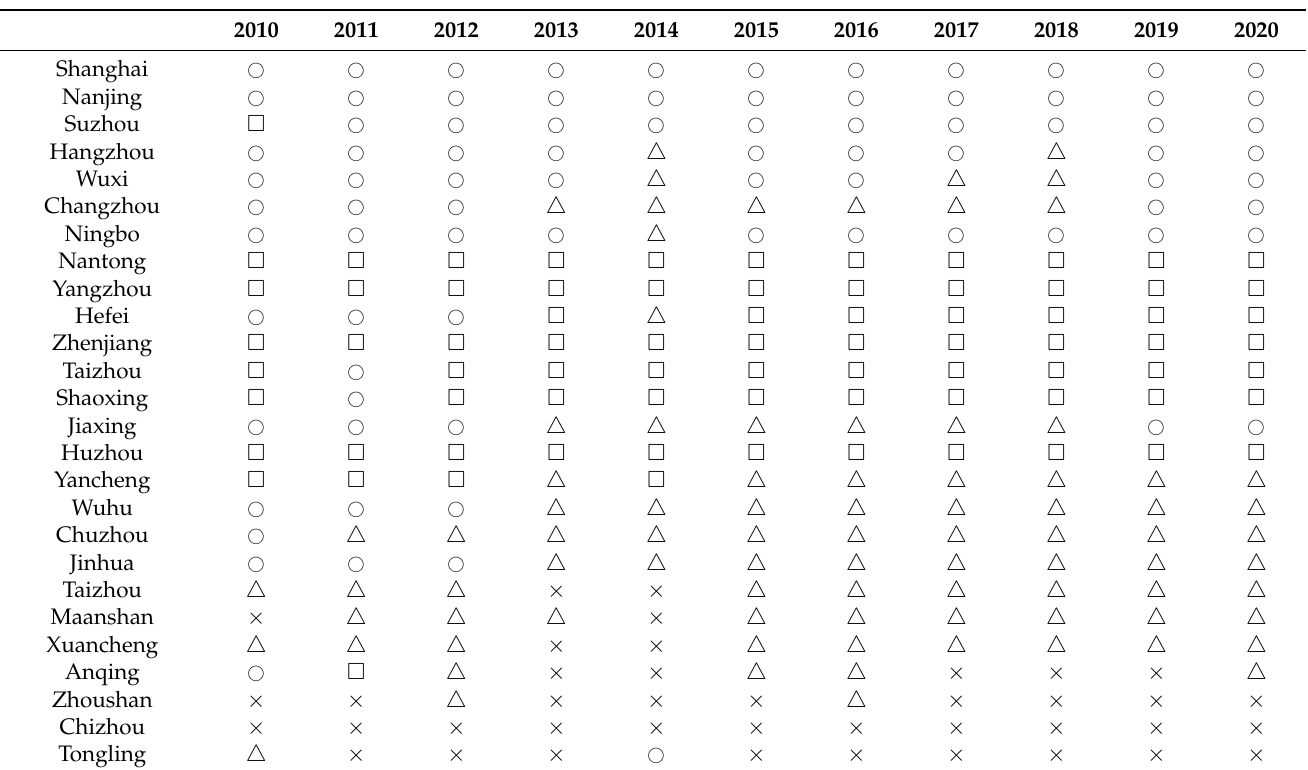
always in the spillover block during the research period, showing a dominant position of the network. Table 8. Results of the block model of a housing prices’ association network in the YRDUA from 2010 to